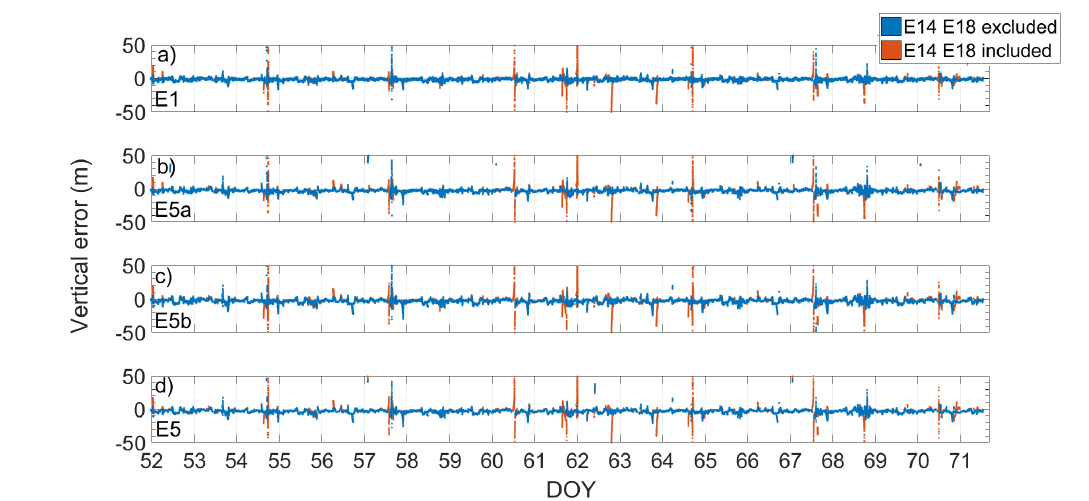
Figure 11. E1, E5a, E5b, and E5 single-point position vertical error time series reported in ( a – d ). Blue and red markers represent errors when the solution was obtained by excluding or including the measurements coming from the Milena (E14) and Doresa (E18) satellites, respectively. The solution was achieved by using broadcast ephemeris.